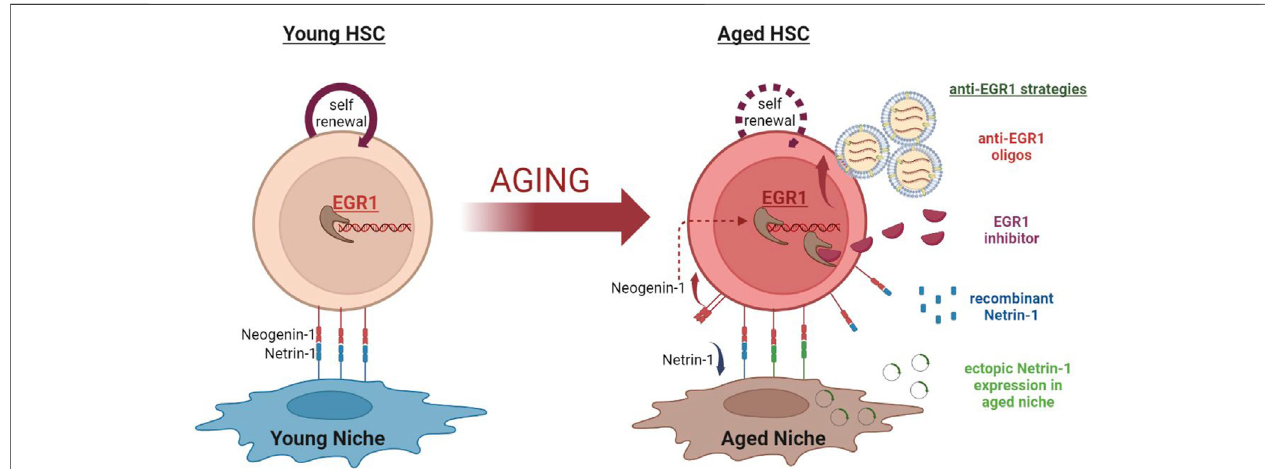
FIGURE 1 | EGR1 targeting strategies for rejuvenation of aged Hematopoietic Stem Cells. The expression of the zinc fi nger transcription factor - EGR1 is signi fi cantly increased in aged HSCs. This is, at least partially, mediated by the aging-associated changes in the BM niche. Increased EGR1 activation in the aged HSCs hampers their self-renewal activity and functions. EGR1 targeting strategies may be used to explore the possibility to rejuvenate aged HSCs. These strategies include - (A) Using the vesicle-mediated transfer of anti-Egr1 oligos speci fi cally targeting aged HSCs. (B) Developing pharmacological EGR1 inhibitors. (C) Treating aged HSCs with recombinant Netrin-1 protein to reduce EGR1 activation in them. (D) Ectopic expression of Netrin-1 in aged BM niche cells to rescue Netrin-1 -Neogenin-1 interaction to modulate downstream EGR1 levels in the aged HSCs.